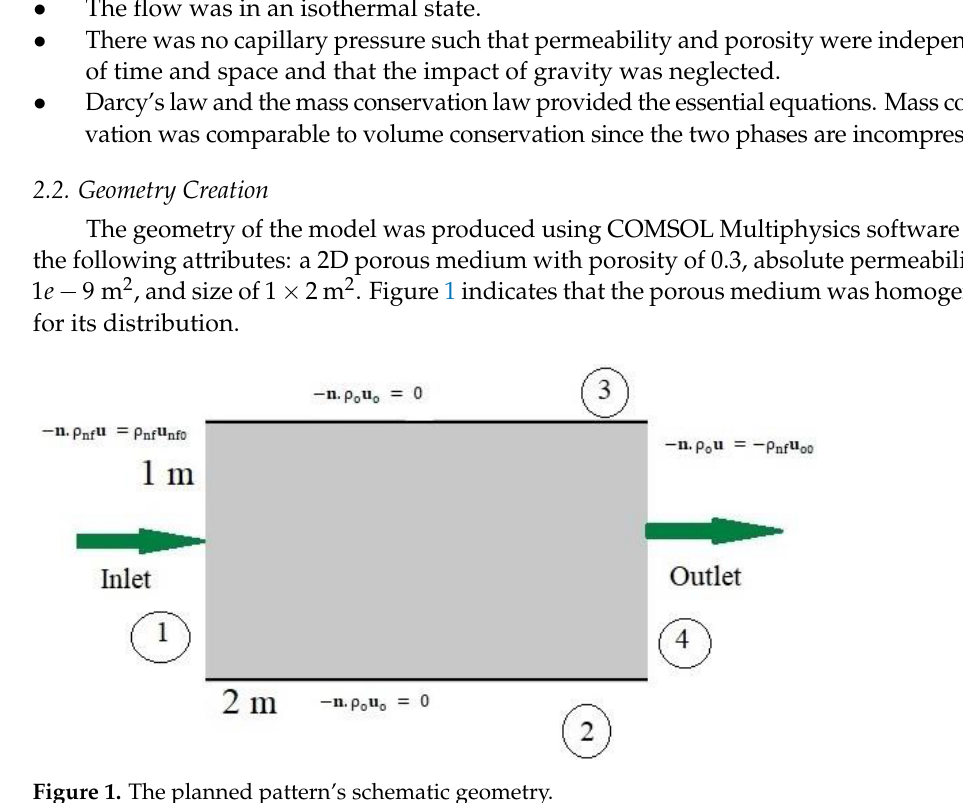
Figure 2. ( a ) Mesh geometry using the boundary layer mesh and ( b ) illustration of the actual structure of the boundary layer mesh. 2.3. Grid Independency Varying grid types with different mesh sizes were developed for the investigation of grid independence. To compare grids, fluid pressure drops in the porous medium were considered. The total pressure at the entrance and exit were estimated. The mesh size, number of elements generated, as well as the pressure drop between the intake and exit are all shown in Table 1. As a result, mesh number 3 is chosen as the ideal mesh number and is utilized in all the simulations that follow. Although COMSOL Multiphysics meshing algorithms attempt to eliminate low- quality parts, this is not always achievable for all geometries. A quality of 1 is the greatest feasible value for any quality measure and signifies an ideal element within the specified quality measure. At the interval ’ s opposite end, 0 denotes a degraded element. As a result of the element measurements, the meshing of the present research geometry is of excellent quality, with a quality of 1, as shown in Figure 3a. In addition, Figure 3b depicts the plot of convergence, which is time – domain convergence for time-dependent problems (variables), and finds a solution to the system of equations with error less than 1𝑒 − 5 at a specific time, 250 s.